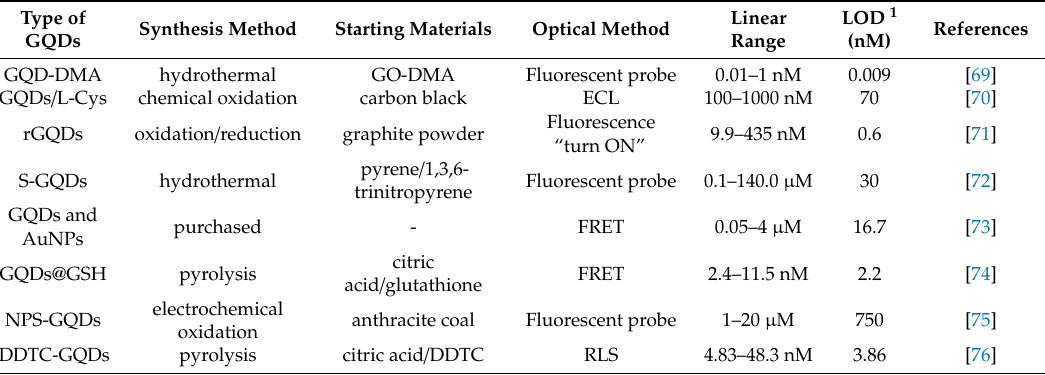
Table 4. The GQDs-based optical sensor for lead ion